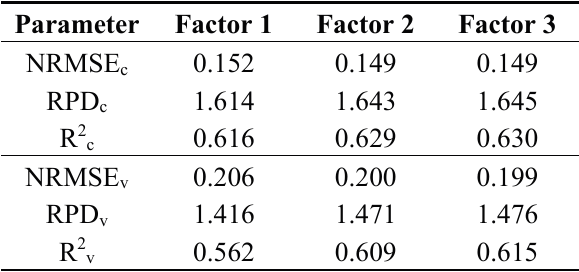
Table 4. Evaluation criteria for PLSR (3).